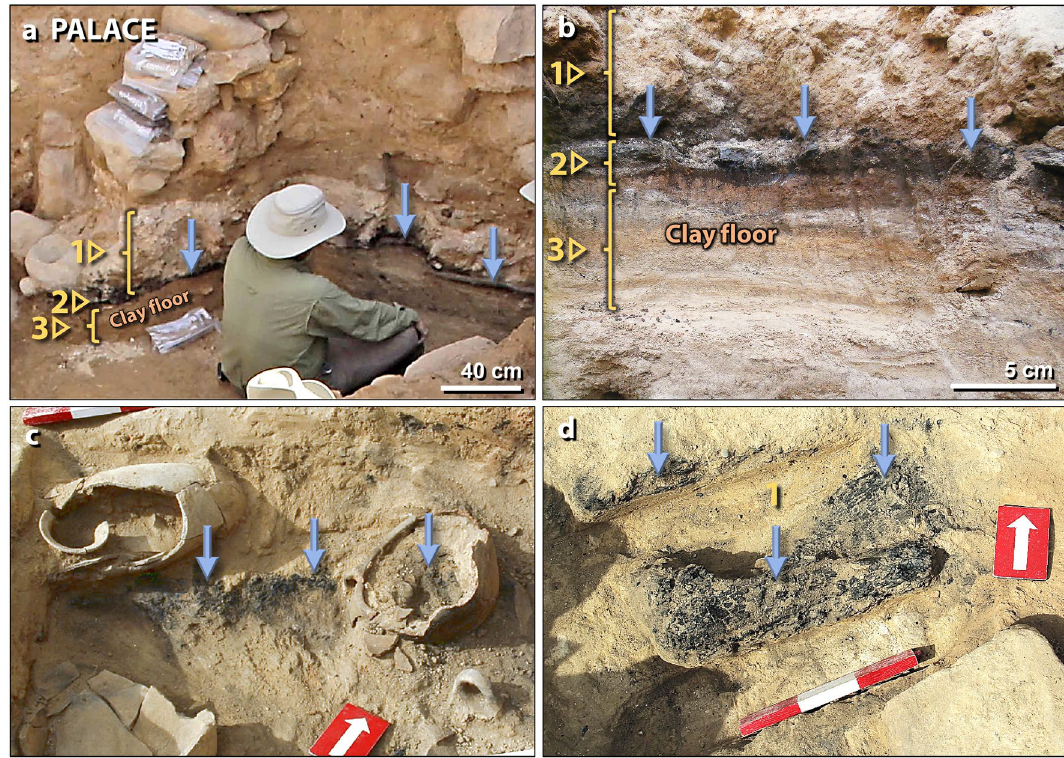
Figure 7. Destruction layer in the palace. ( a ) Photo of excavation in an exterior food preparation area of the palace. #1 marks MB II debris that was most likely deposited by post-fire erosion. #2 points to charcoal-rich ‘dark layer’ indicating a major fire in the palace. Contains fragments of plaster and limestone spherules. Blue arrows mark its top. #3 points to the cross-section of excavated clay flooring. ( b ) Close-up photo of the same palace sampling sequence as in panel ‘ a ’. ( c ) Photo of broken pots with carbonized grains embedded in MB II 1.5-m-thick debris matrix, mostly composed of pulverized mudbrick and plaster fragments and limestone spherules. Debris matrix is found in the space between all palace walls. Note charcoal inside the broken pot. The end of a scale stick with 10-cm divisions is at upper left. ( d ) Charred palace roof timber surrounded